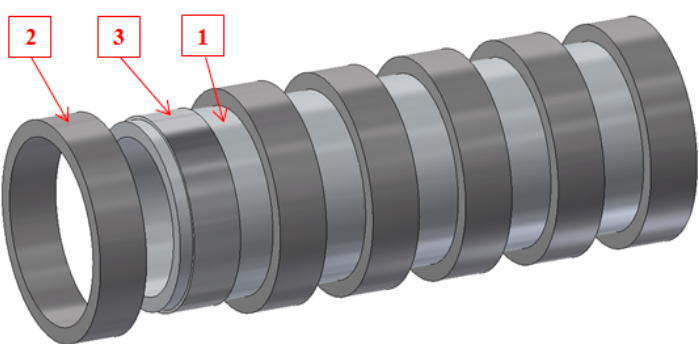
Figure 5. Core prepared for sample winding; 1—core (mandrel), 2—steel ring, 3—steel insert. Five samples were manufactured to conduct the tests, and for each sample the value of the tension of the fibres (rovings) was different. The parameters of the samples were shown in Table 1. Parameters of carbon fibre-reinforced polymer (CFRP).